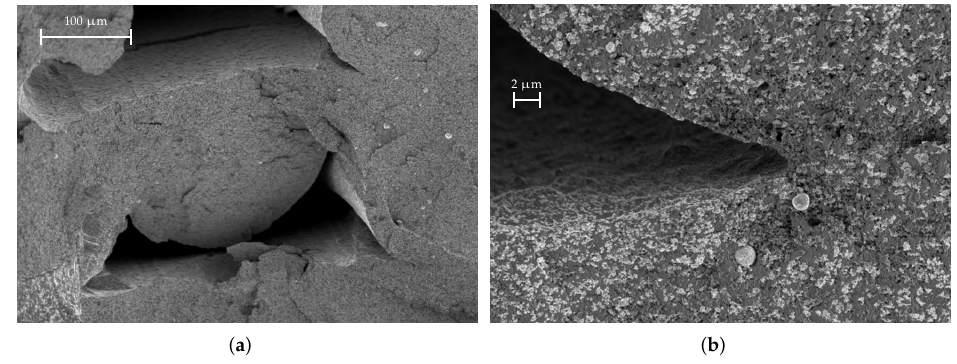
Figure 14. SEM images of a printed CDP material sample. ( a ) CDP, medium magnification; ( b ) CDP, large